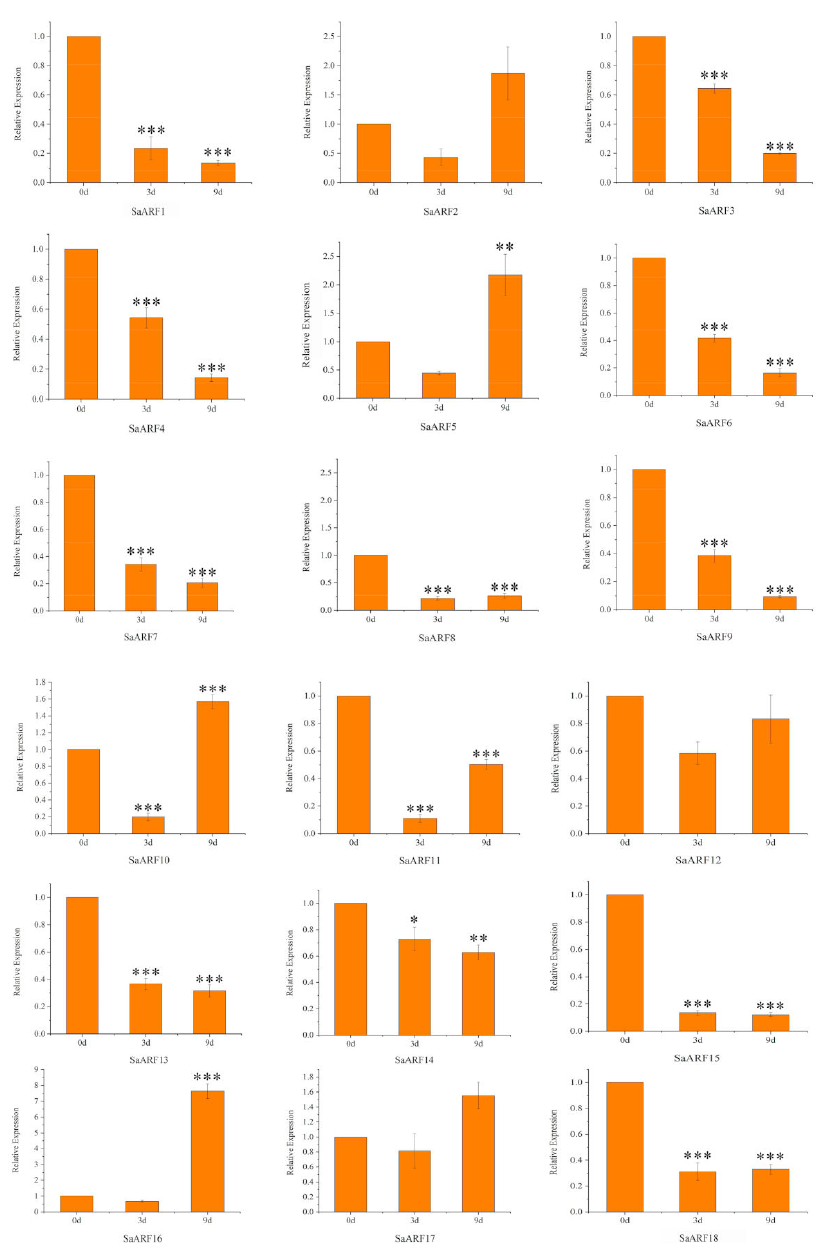
Figure 11. Expression analysis of Sa ARF genes in response to drought stress by qRT-PCR. Drought for 0 d, 3 d, 9 d in a greenhouse environment. The data were presented as the mean ± SD of three separate measurements. Asterisks denote significant differences: * p < 0.05; ** p < 0.01; *** p <